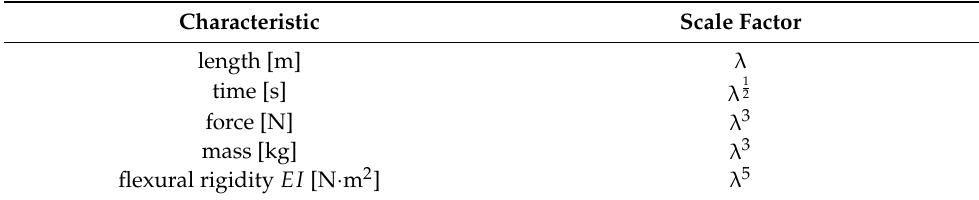
Table 1. Scale factors using Froude scaling.